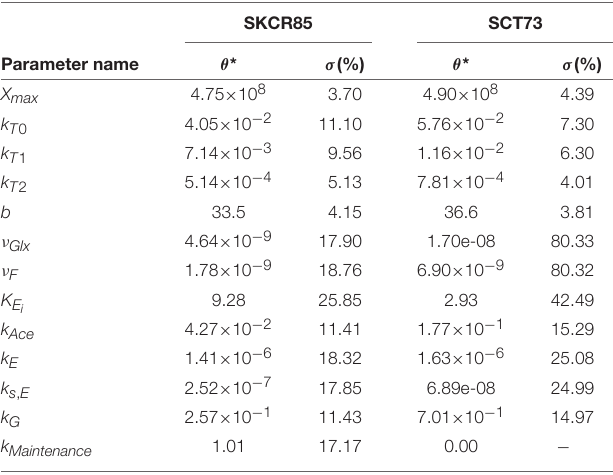
TABLE 2 | Mean values of the parameters ( θ *) obtained for each strain and the corresponding standard deviation ( σ ) across the bootstrap estimations. SKCR85